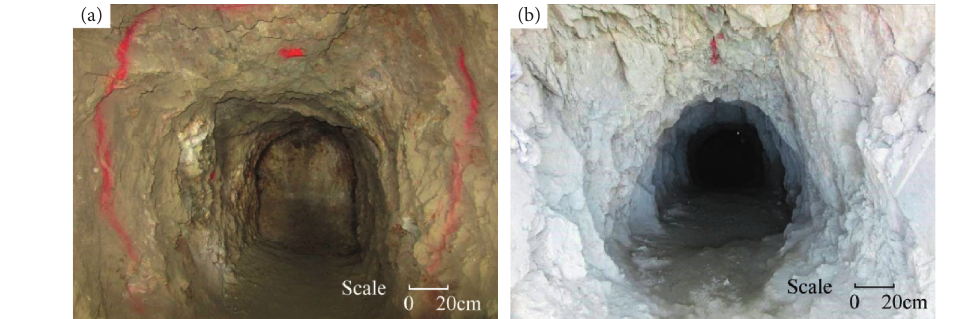
Figure 5: (a) Left tunnel and (b) right tunnel of model anchors.